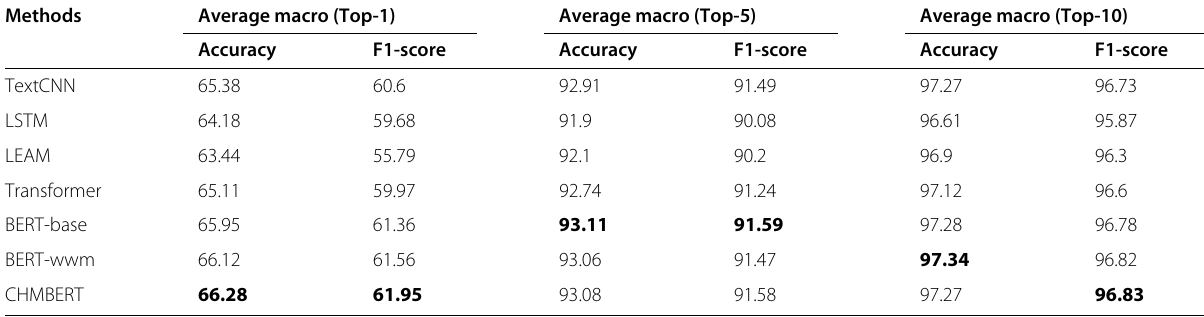
Table 1 Average macro accuracy and F1-score for disease prediction